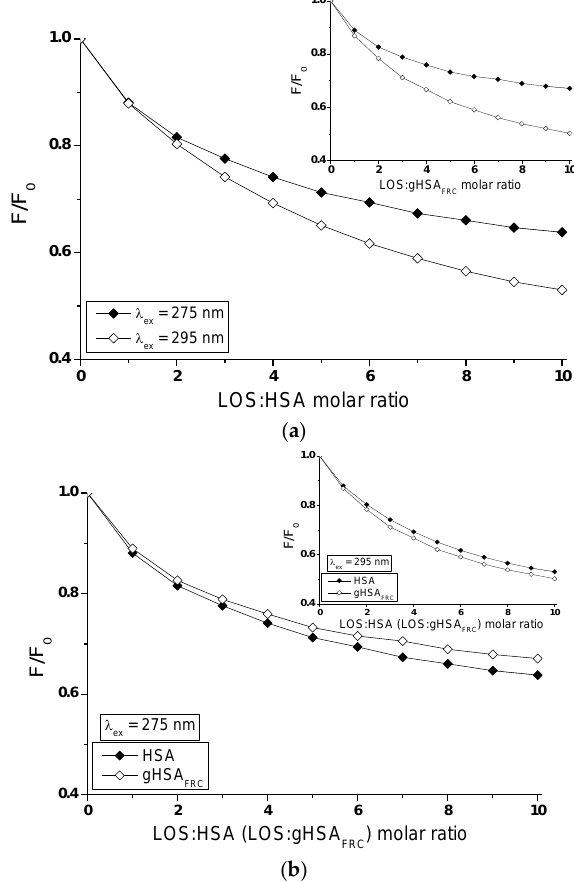
Figure 11. Quenching fluorescence of HSA and gHSA FRC containing 5 × 10 −6 mol∙L −1 –5 × 10 −5 mol∙L −1 concentrations of LOS. Albumin concentration: 5 × 10 −6 mol∙L −1 ; ( a ) LOS-HSA ( main view, ) and LOS- gHSA FRC (insert, ); ( b ) λ ex = 275 nm (main view, ) and λ ex = 295 nm (insert, ); the error bars are smaller than the symbols.